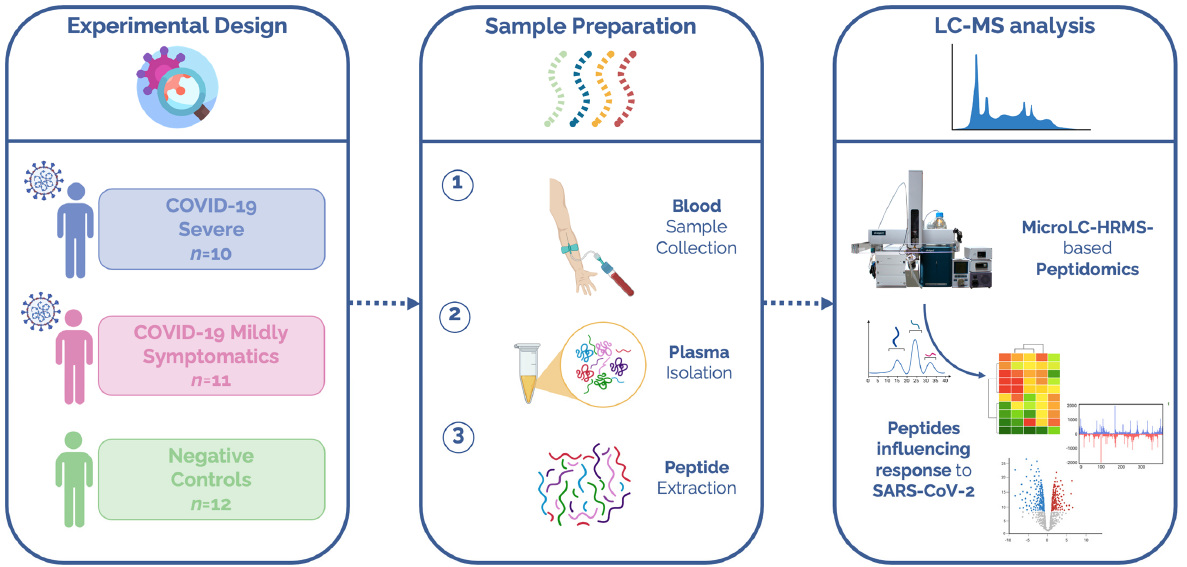
Figure 1. Experimental design of the study. Plasma samples from subjects who tested negative for COVID-19 ( n = 12) and from COVID-19 positive patients divided into two groups depending on disease severity, namely, severe ( n = 11) and mildly symptomatic patients ( n = 12), were used. Circulating peptides were extracted through a strong anion exchange sorbent. Peptides were then characterized using an LC-MS system and the identified and modulated peptides were elaborated with bioinformatics to identify peptides influenced by SARS-CoV-2